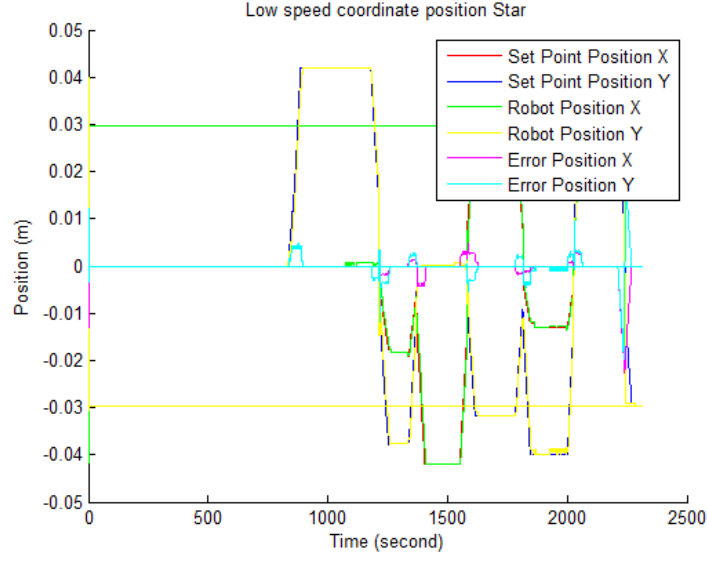
Figure 25. Position coordinates for low speed.